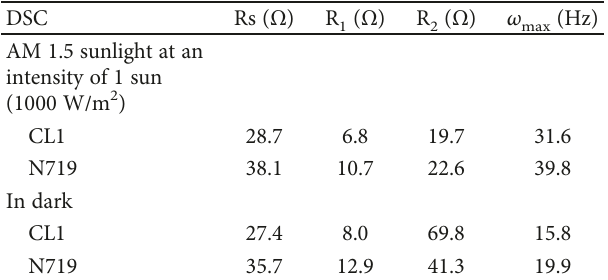
Table 2: Electronic device parameters obtained by fi tting the EIS data to the equivalent circuit model (Figure